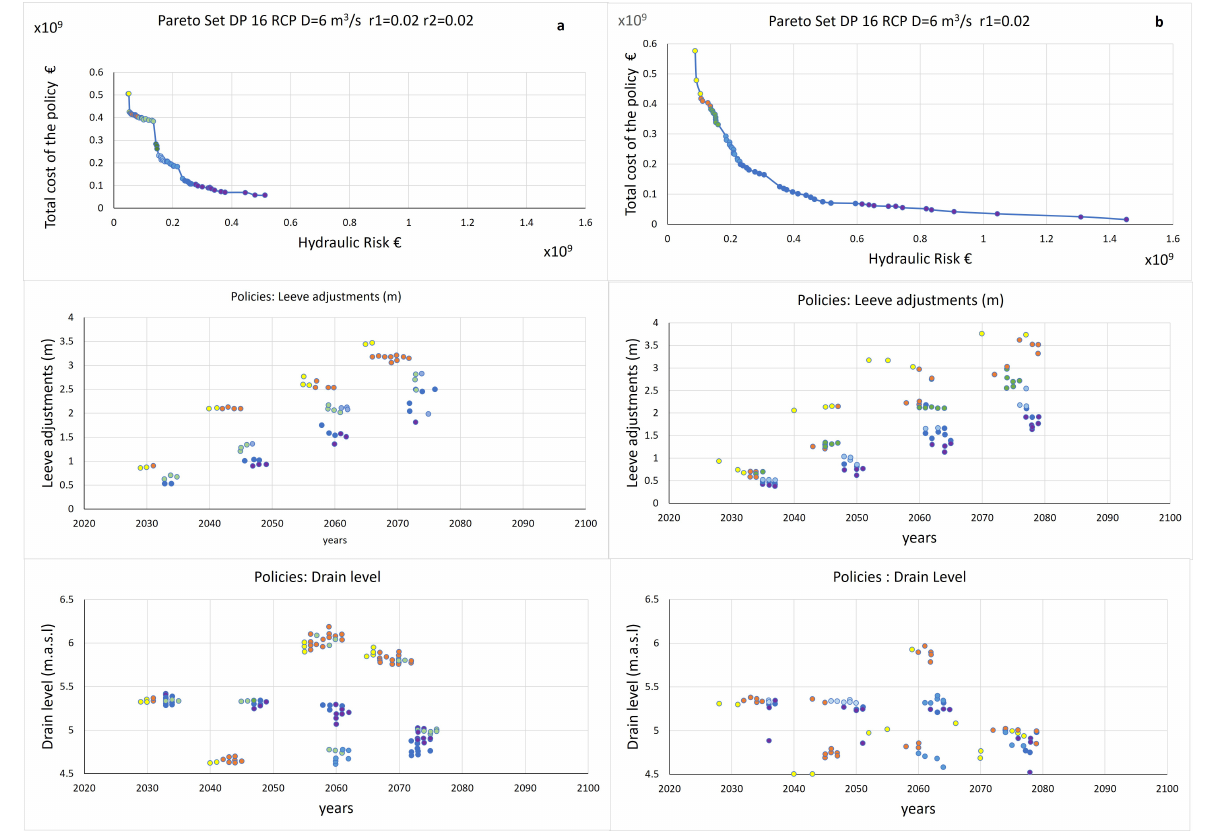
Figure 18. ( a , b ) Size and timing of Flood defence constructions for the Pareto set optimal solutions referred to scenario 5 of Table